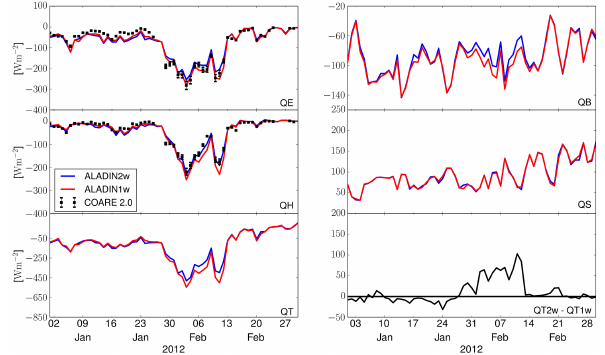
Figure 8. Same as Fig. 6 but for Acqua Alta location.